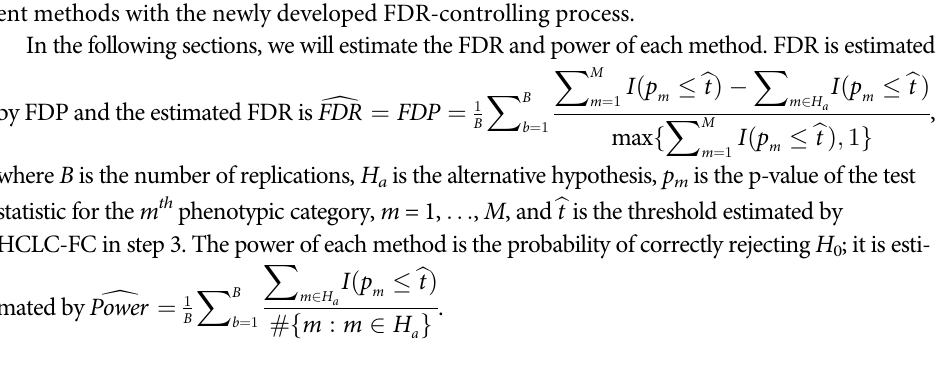
ffiffiffiffiffiffiffiffiffiffiffiffi 1 (cid:0) c 2